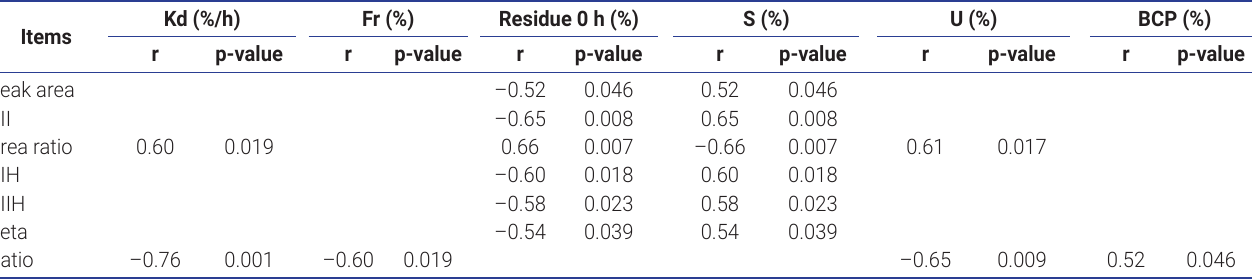
Table 15. Correlation study between FTIR protein structures and the protein portions of the in situ rumen incubation of canola seeds